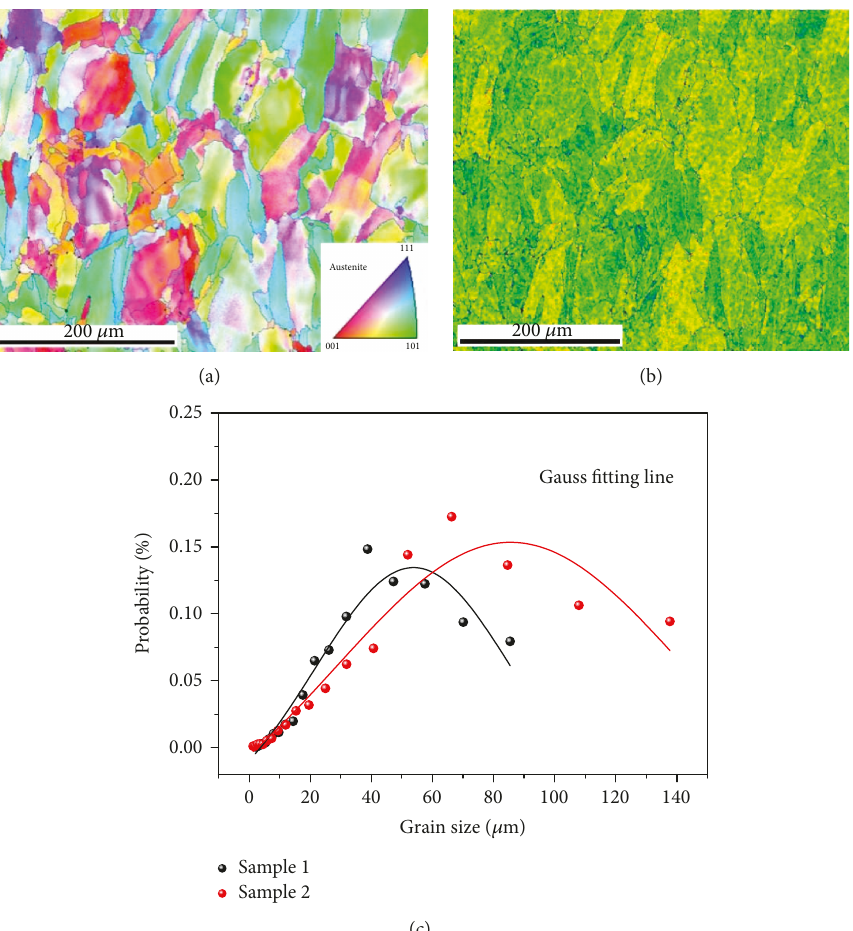
Figure 22: (a) Inverse pole fi gures of sample 1 through EBSD and (b) kernel average misorientation map and (c) grain size